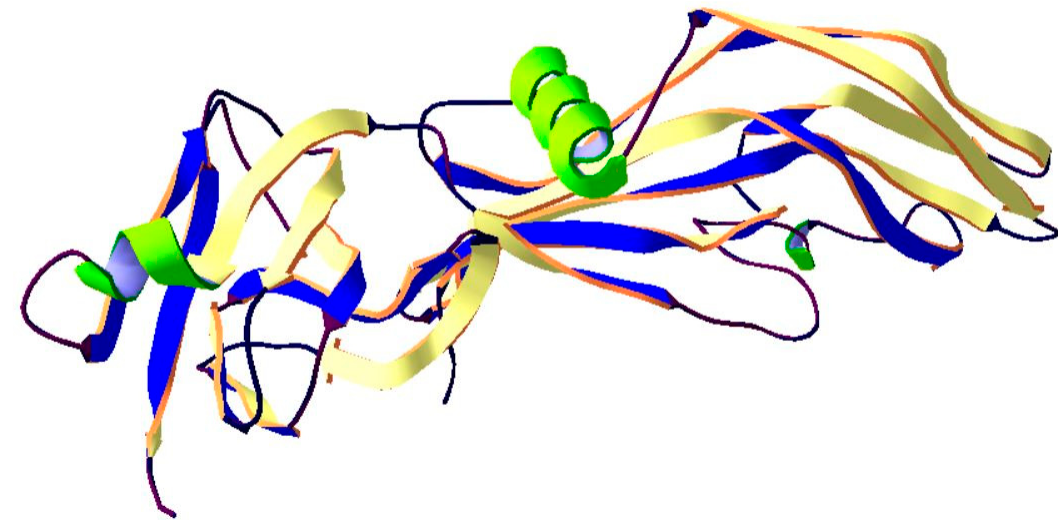
Figure 3. Structure of C. Perfringens enterotoxin. The crystal structure of protein (PDB: 3AM2) [68] was taken from the RCSB PDB databank (http://www.rcsb.org/) (access on 22.02.2019). Visualization of the three-dimensional structure of the protein was performed using the Swiss-PdbViewer (http: //spdbv.vital-it.ch/) (access on 05.03.2018).